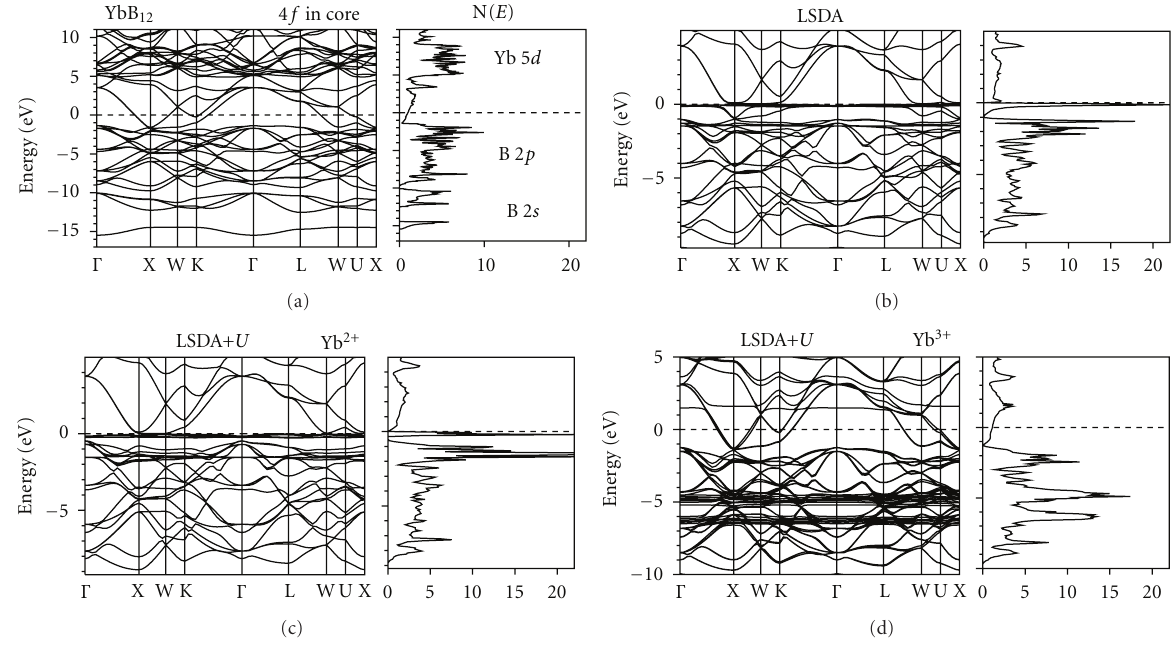
Figure 56: Self-consistent fully relativistic, spin-polarized energy band structure and total DOS (in states/(unit cell eV)) calculated for YbB 12 with LSDA and LSDA+ U approximations